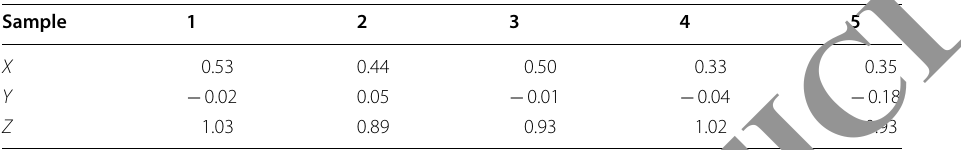
Table 2 Samples of linear motion data